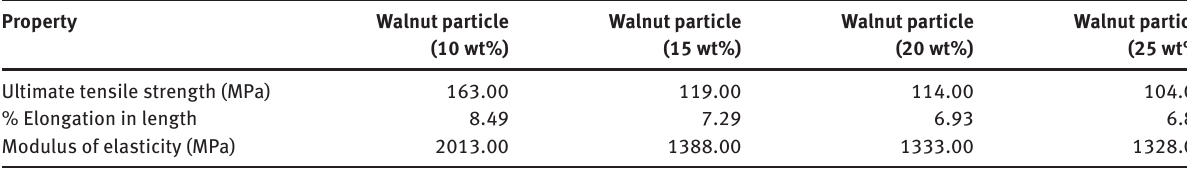
Table 3 Tensile properties of the composite materials.